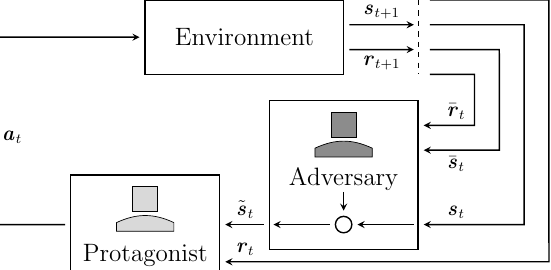
Figure 8. Illustration of observation robust designs. The adversary distorts the states or the protago- nist’s perception of the states. As consequence, the protagonist makes detrimental decisions. The design relies on the vulnerability of neural networks to input